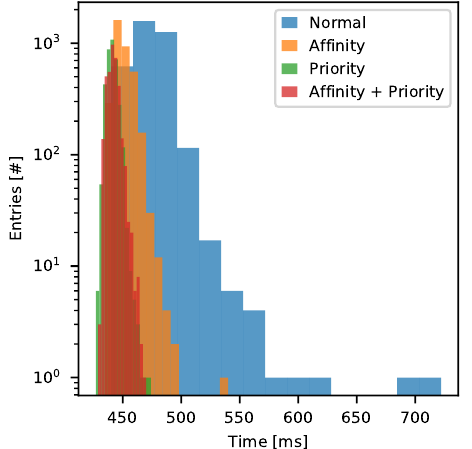
Figure 17. Performance of the Stimulation Stream Builder inserting 10,000 current pulses into 0.5s Output Bitstream chunk. The distributions were obtained using different combinations of system processes scheduling options. Normal data was gathered when the operating system was given no additional preferences about running Neurostim-3 Data Acquisition (DAQ) processes. Affinity case reflects measurement when Stimulation Stream Builder process was assigned to the specific Central Processing Unit (CPU) core while the other DAQ processes were prohibited from running on that core. Priority data was taken with Stimulation Stream Builder process with assigned high priority, while the rest of them were set up to run below normal priority. Affinity + Priority is the combination of two of them. All stress tests passed without failure due to the Output Bitstream